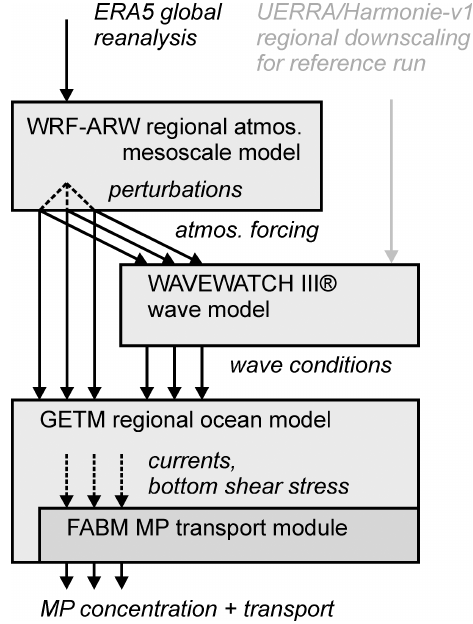
Figure 1. Schematic overview of the model chain used in this